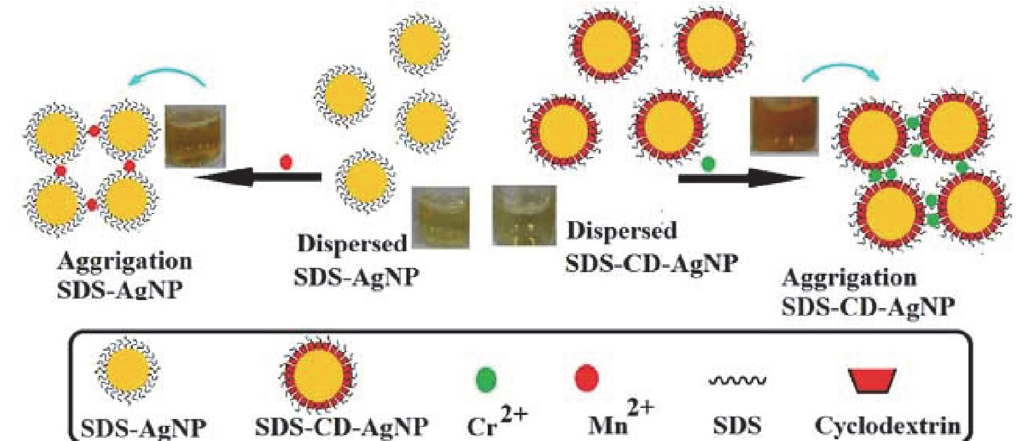
Figure 1. Schematic illustration of detecting mechanism of Mn 2+ and Cr 2+ ions based on the aggregation of SDS-AgNPs and SDS-CD-AgNPs, re-